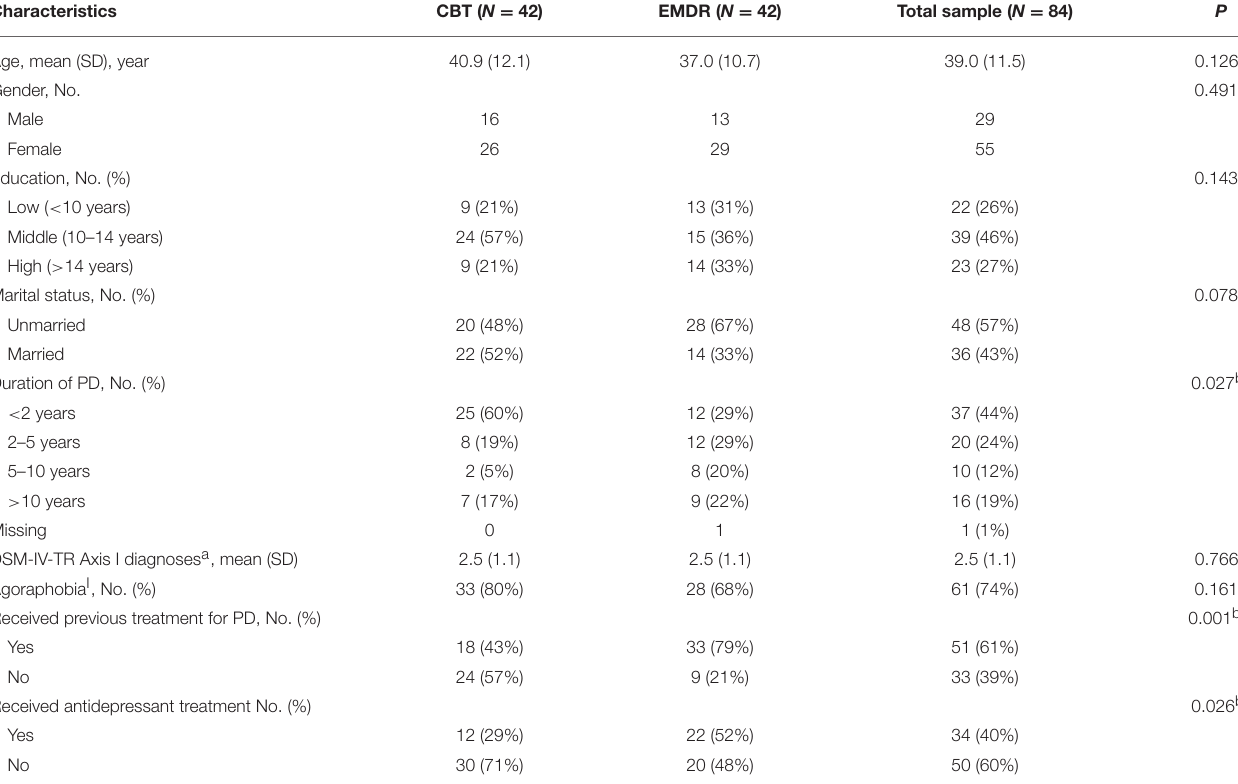
TABLE 1 | Baseline demographic and clinical